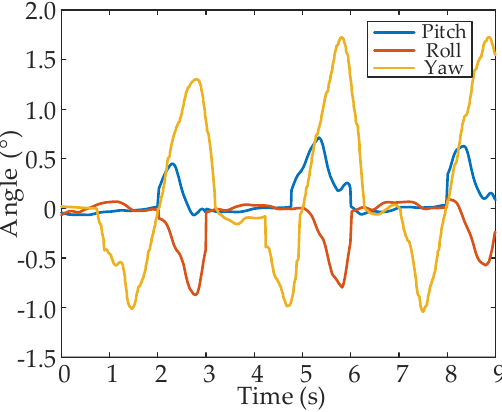
Figure 28. Contact force in leg 2 failure experiment.